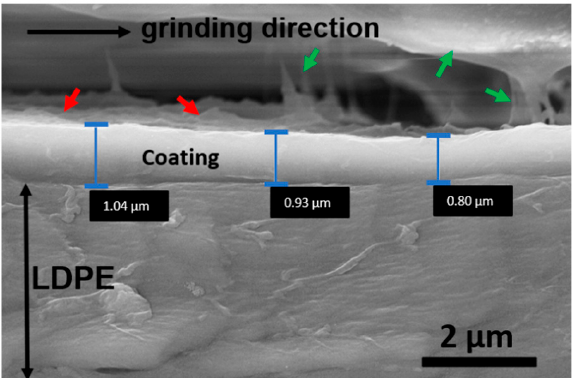
Figure 2. SEM micrograph of a cross-sectional coating deposited on an LDPE substrate. The thickness of the coating is indicated in three different regions.